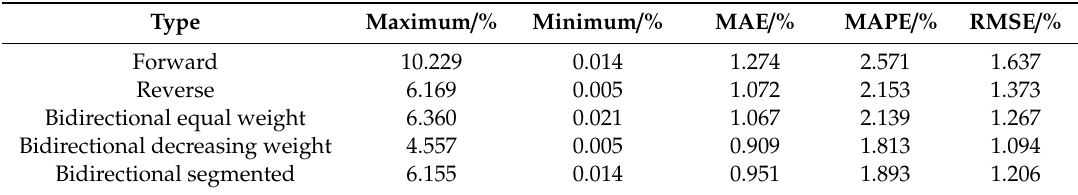
Table 4. The prediction error of LSTM models.